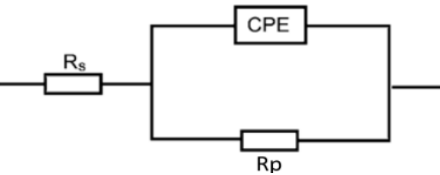
Figure 5. Nyquist plots for Al corrosion 0.1 M NaOH medium and with, ( a ) Amygdalin (Amy), and ( b ) Raffinose (Raf) at 298 K.